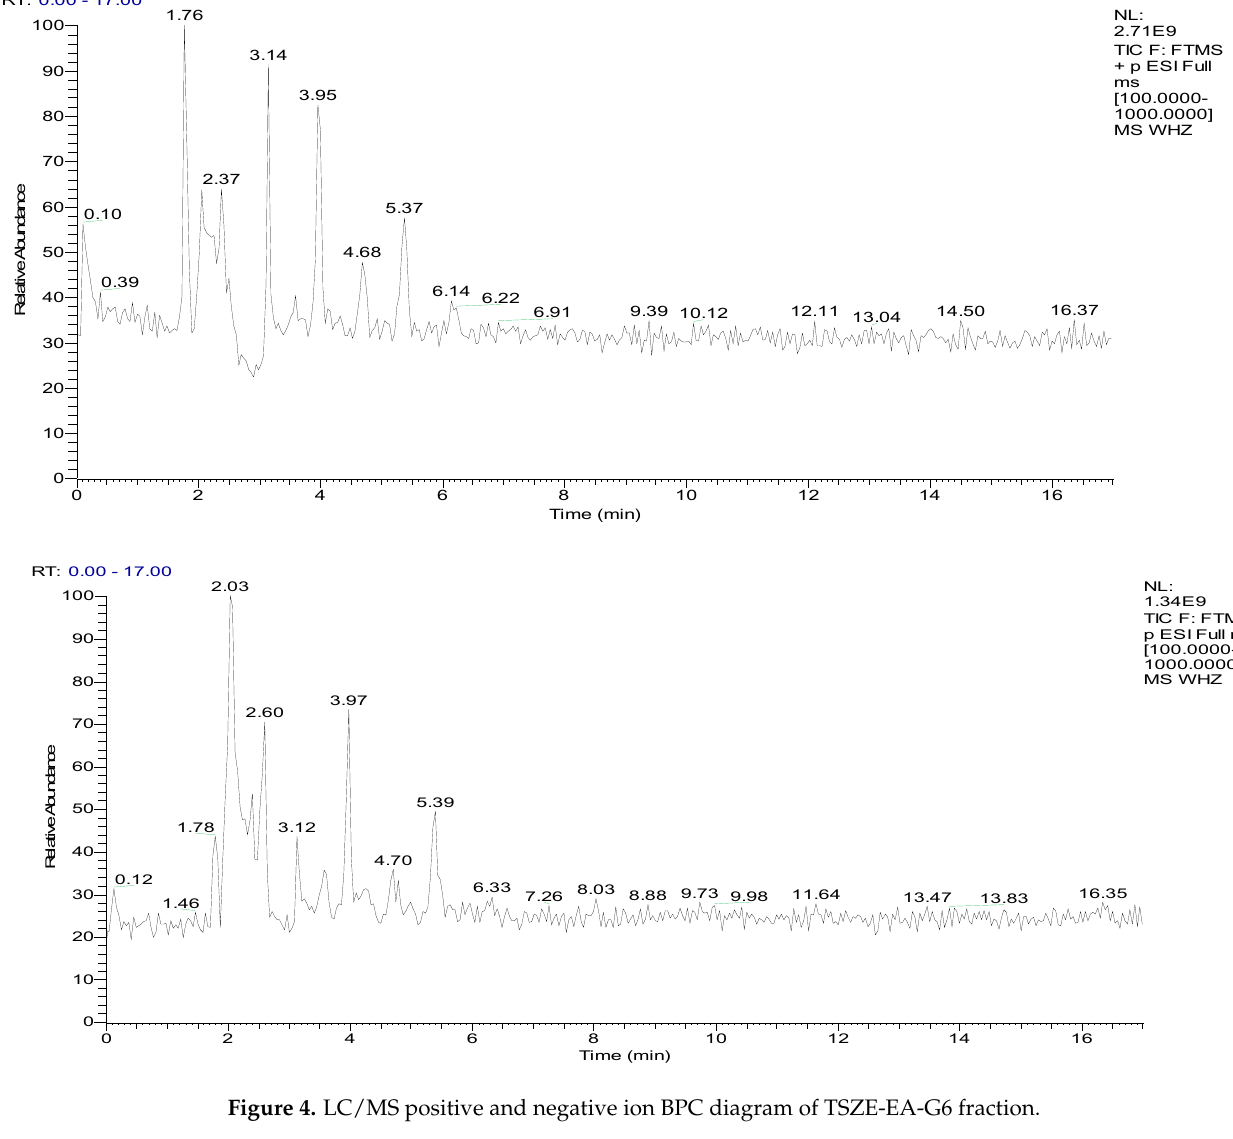
Figure 4. LC/MS positive and negative ion BPC diagram of TSZE-EA-G6 fraction. According to Table 3, the components of the TSZE-EA-G6 fraction were mainly flavonoids and quinic acid compounds [13]. However, in order to clarify the active compo- nents promoting NSCs proliferation, the monomer compounds should be